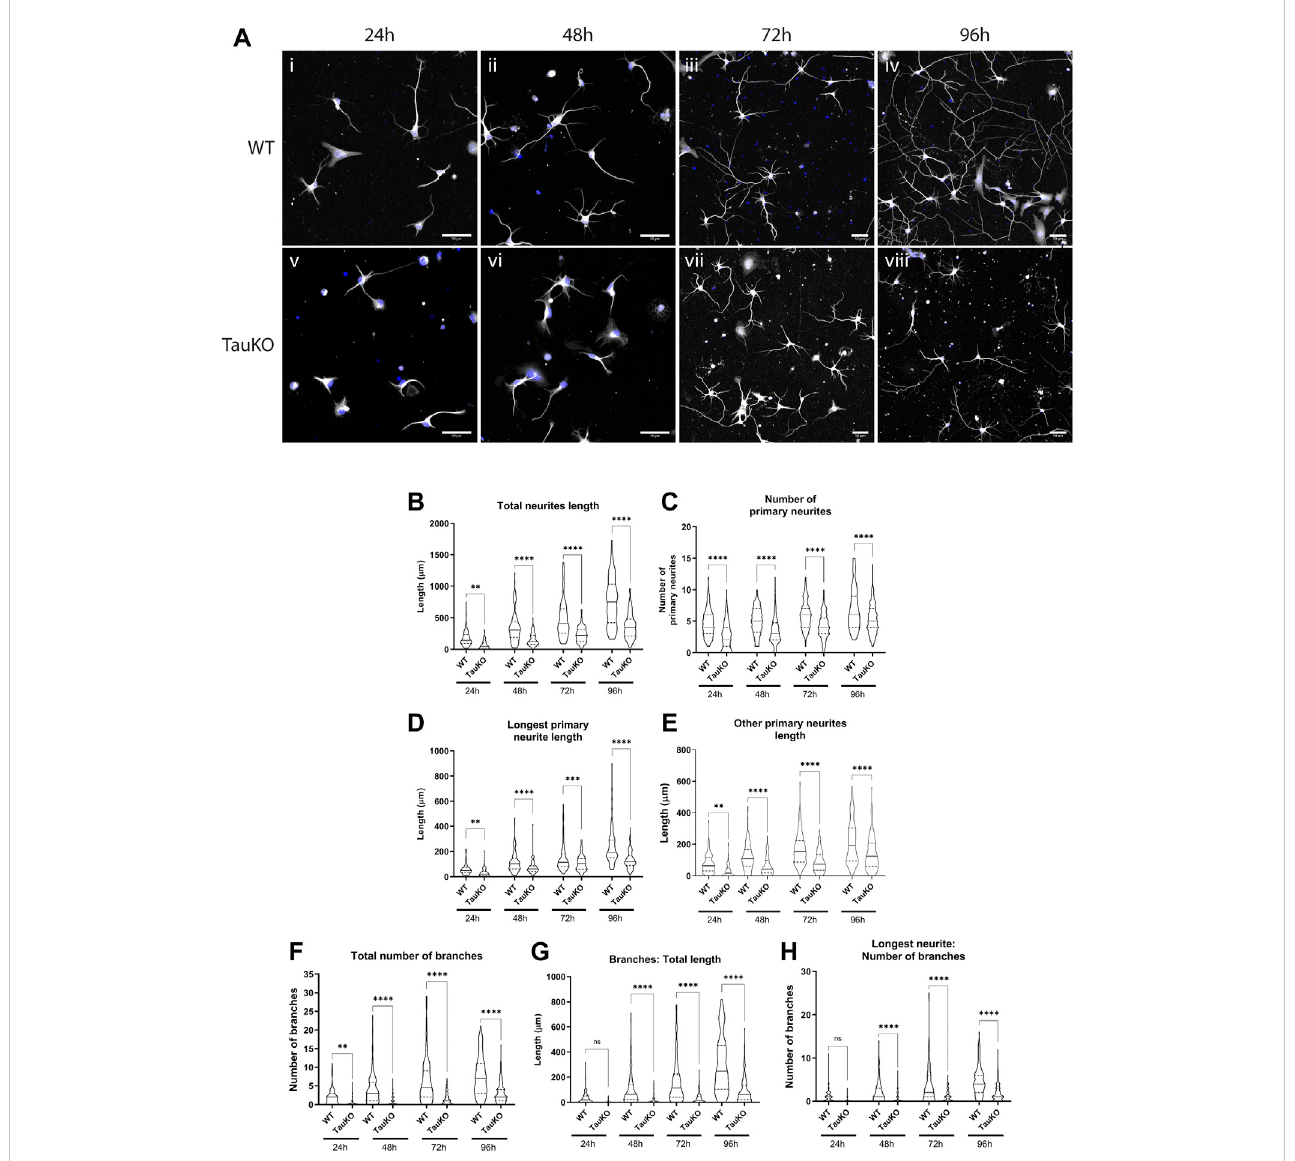
Tau KO hippocampal neurons have impaired neurite outgrowth and branching compared to WT neurons. Primary hippocampal neurons from WT and tau KO mice were cultured on poly- L -lysine + laminin for 24, 48, 72, or 96 h followed by staining for β 3-tubulin. (A) WT hippocampal neurons (i – v) progress